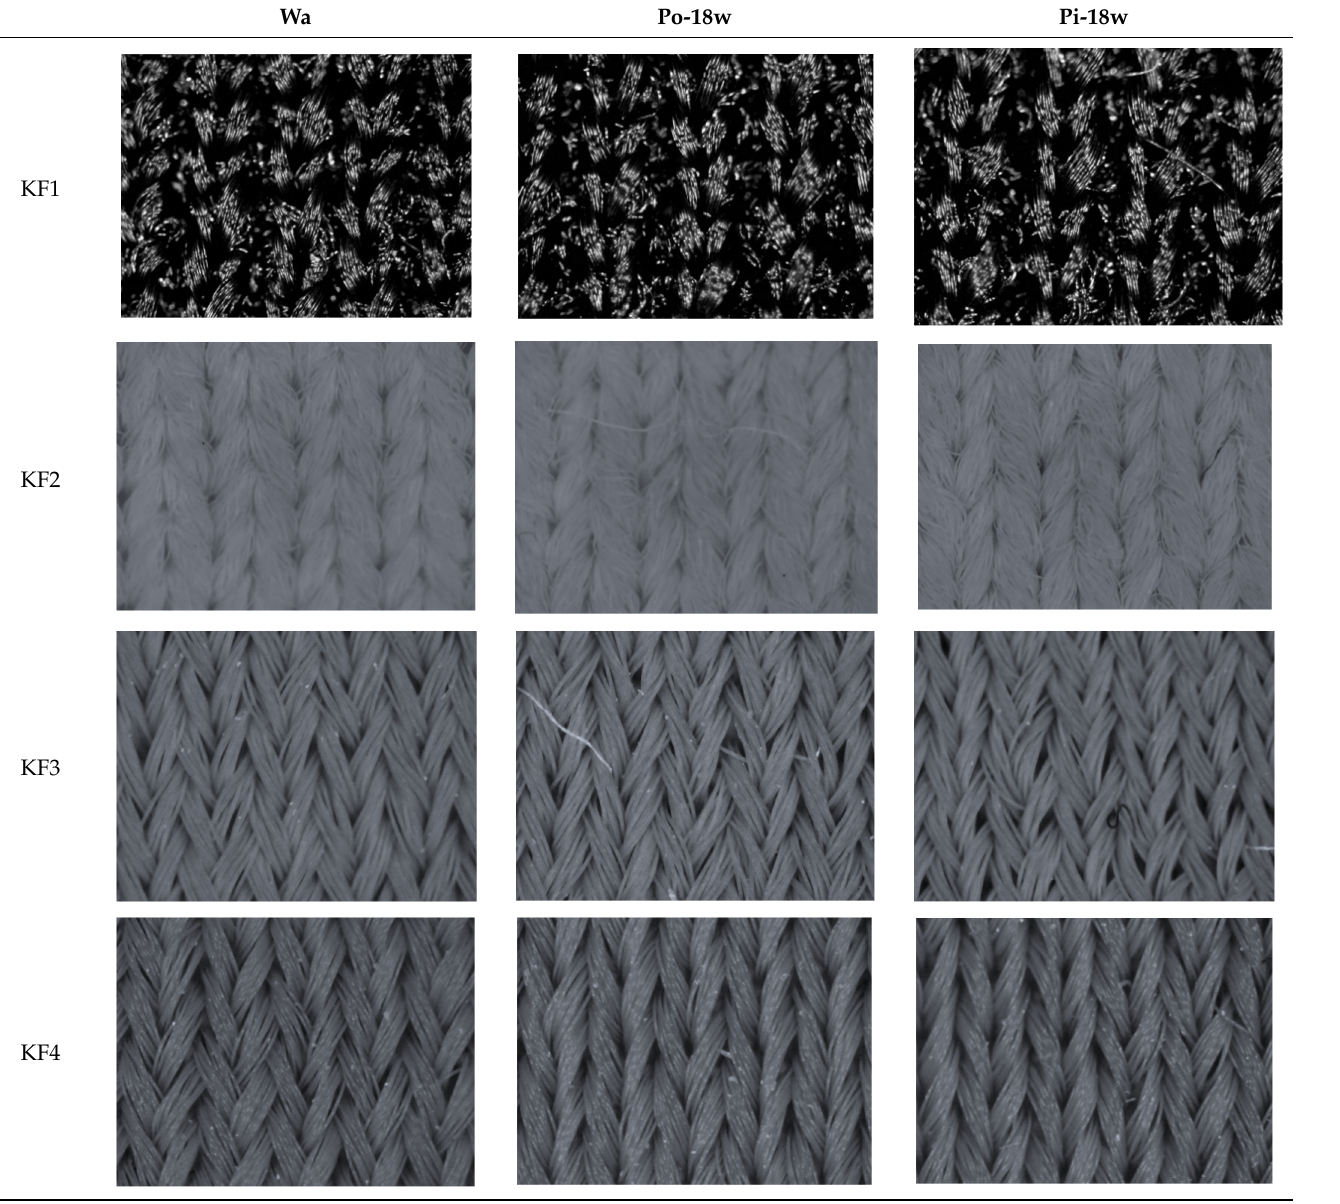
Table 3. Microscopic images of the materials before aging (wa) and after three weeks of aging outdoor (Po-18w) and indoor (Pi-18w).